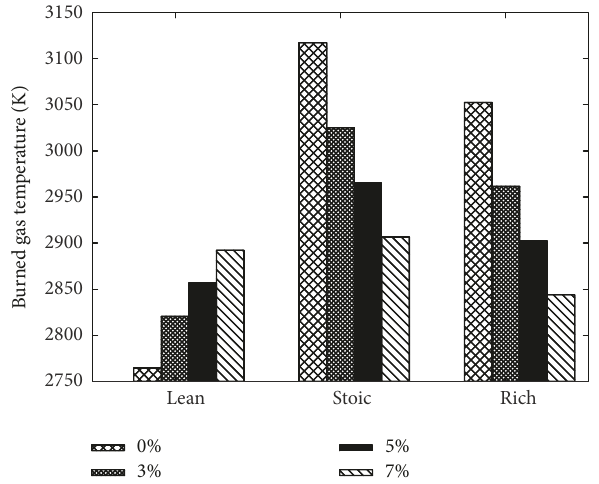
Figure 8: Effect of RGF and equivalence ratio on maximum burned gas temperature